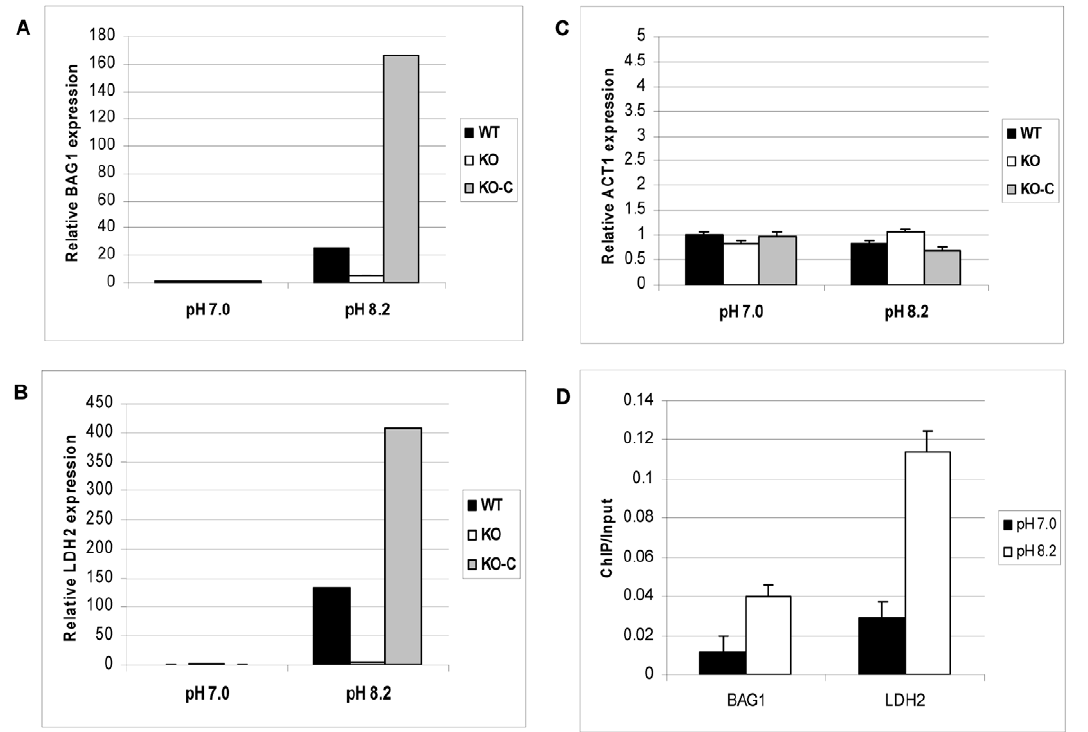
Figure 6. D GCN5-A parasites fail to up-regulate developmental genes in response to alkaline pH. Wild-type (WT), D GCN5-A (KO), or complemented D GCN5-A (KO-C) parasites were incubated in control (pH 7.0) or alkaline media (pH 8.2) for four days. The levels of mRNA expression for stress-induced bradyzoite genes BAG1 (A) and LDH2 (B) or the constitutive gene actin, ACT1, (C) were monitored by quantitative real-time PCR. Error bars indicate the S.D. D. ChIP of FLAG-tagged TgGCN5-A performed as described in Fig. 5, but using primers for BAG1 and LDH2 (Table S6). Results are represented as a ratio of ChIP/Input DNA. P value for BAG1 sample=0.02, P value for LDH2 sample=0.01 (Student’s t-test).